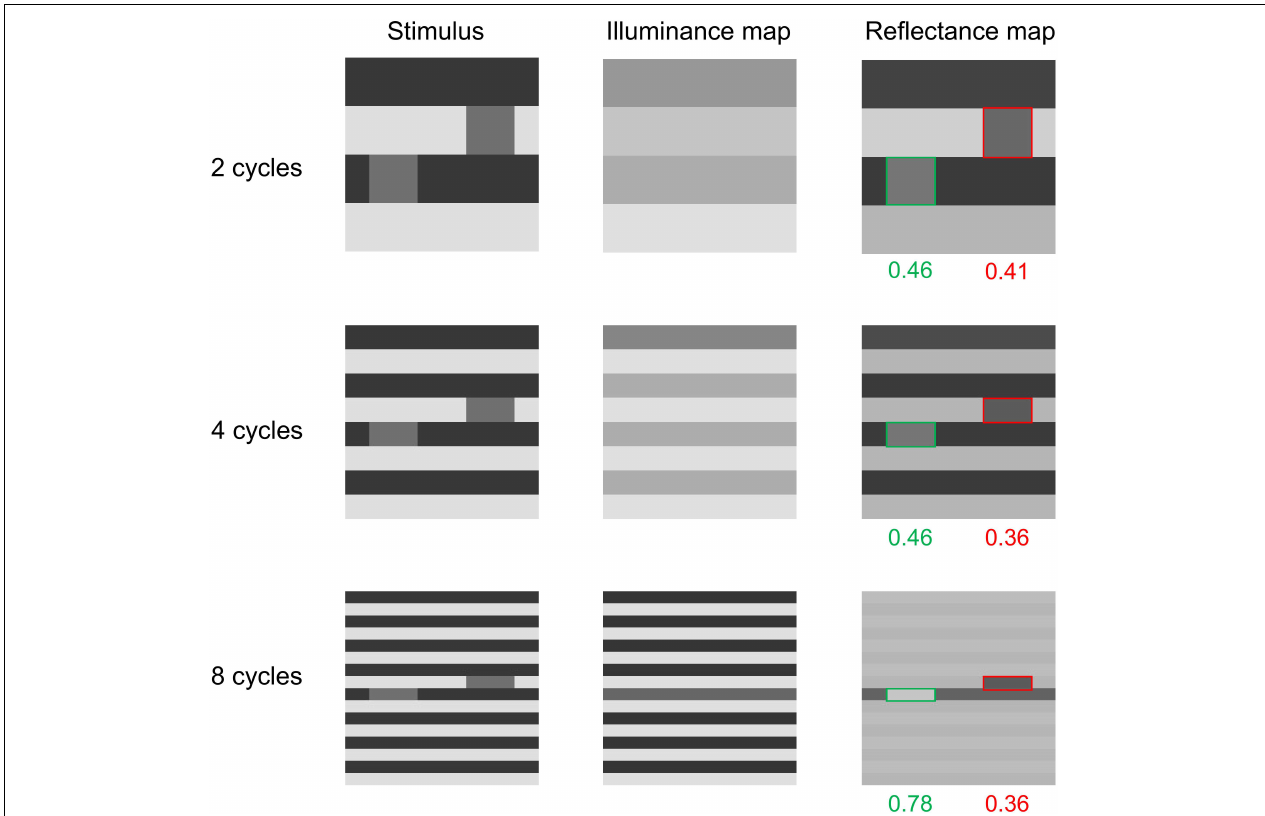
FIGURE 7 | Effect of stripe frequency on the modified model’s output. The modified model predicts stronger illusions as the stripe frequency